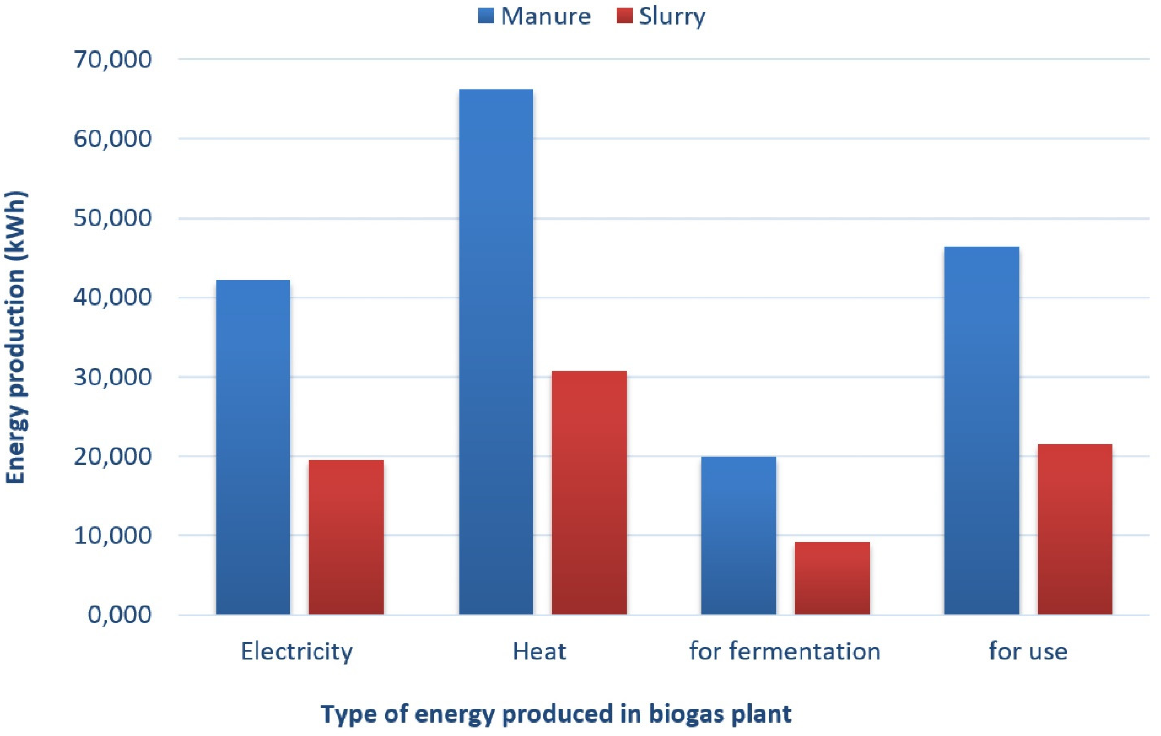
Figure 4. Biogas and biomethane production from 20 cows on farmland. Own study based on Source: [41].